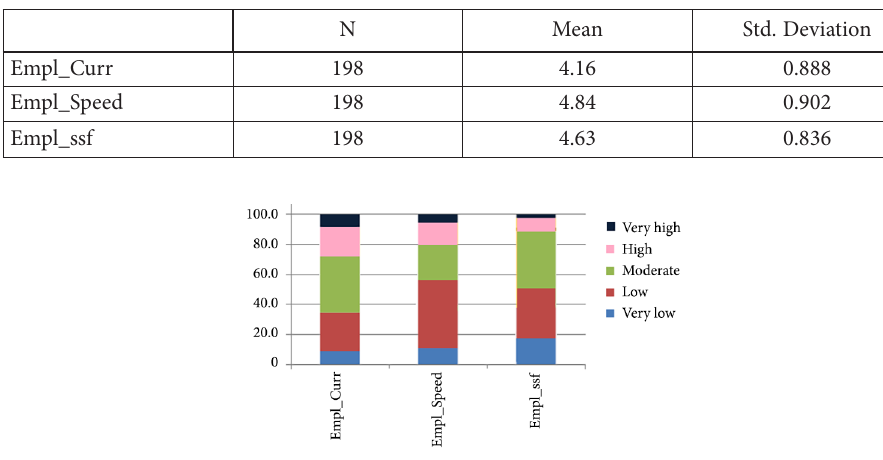
Figure 6. Respondents’ viewpoints regarding the variable employees’ access to